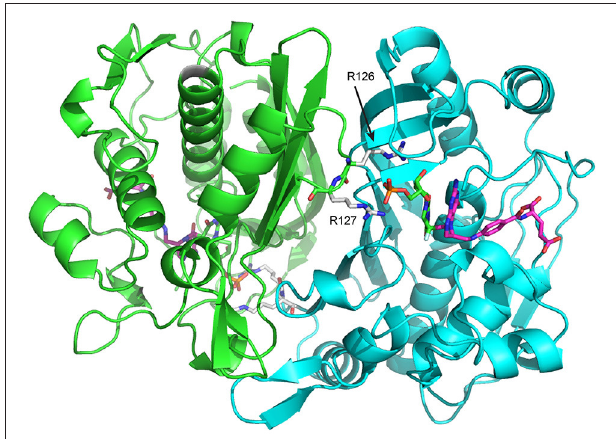
FIGURE 2 | E. coli Thymidylate synthase (ecTS) homodimer structure with substrate and cofactor bound (“diligand,” or intermediate II in Figure 1 ). Each protomer is shown in green/cyan. In the cyan protomer, dUMP (carbon = green sticks) phosphate is contacted by R126 and R127 from the green protomer and is covalently attached to mTHF (carbon = magenta sticks). The pdb file used is